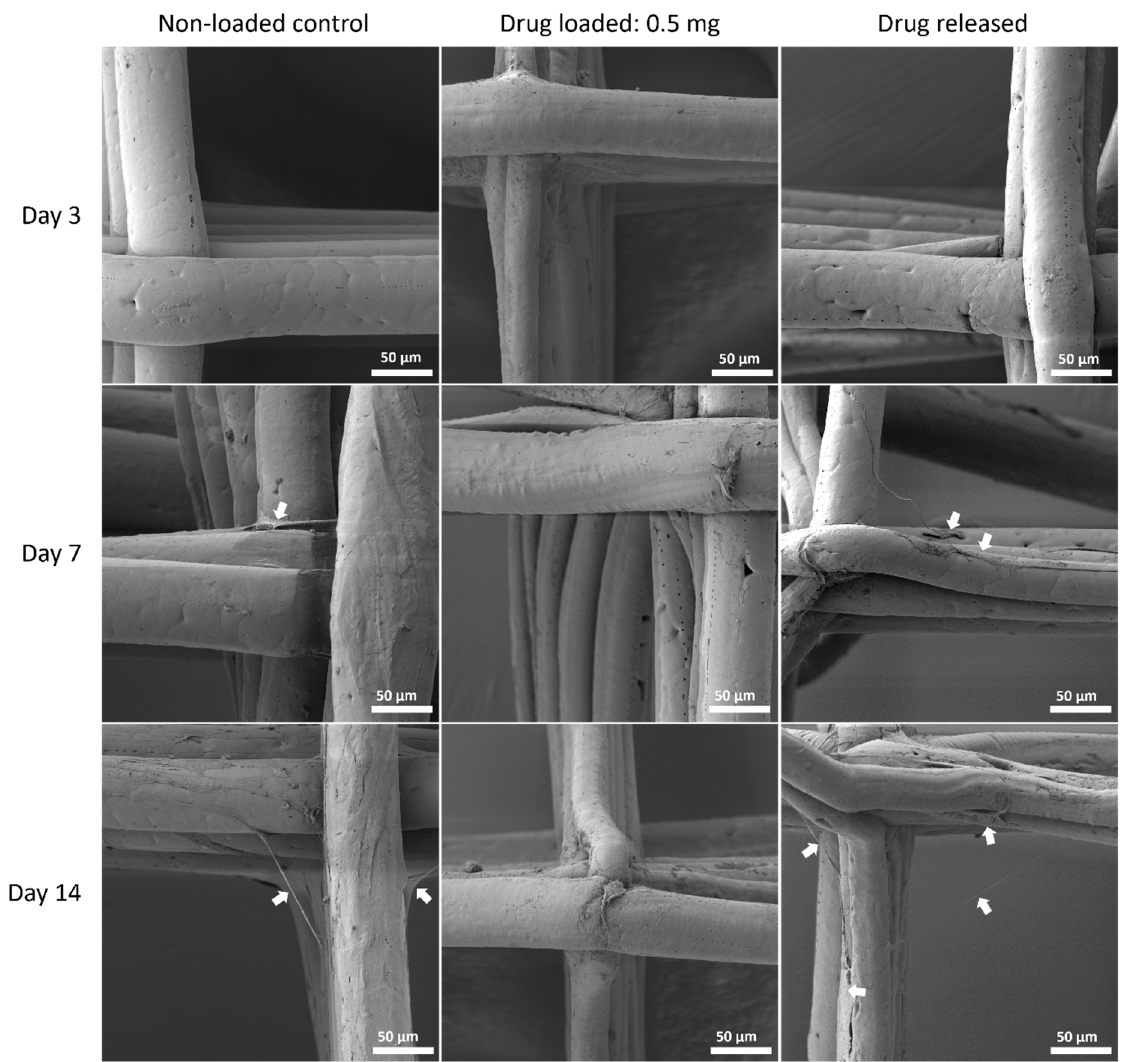
Figure 11. MSC cell morphology on PCL/PEG 90:10 mesh groups at all time points by SEM. Arrows pointing at representative cells or cell sheets attached on mesh fibres.